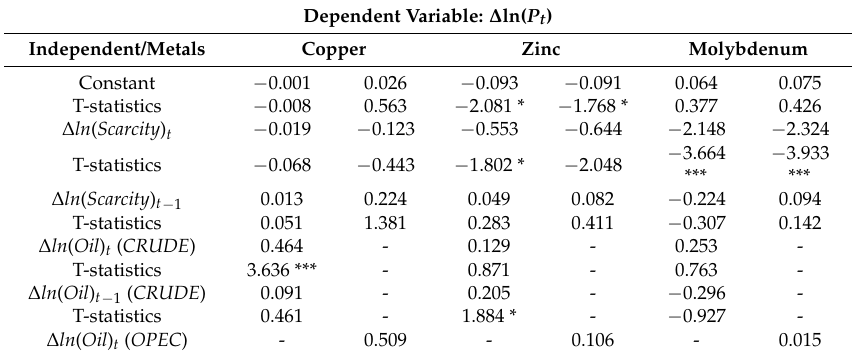
Table 1. The regression results of Equation (2) for copper, zinc and molybdenum, 1991–2015.